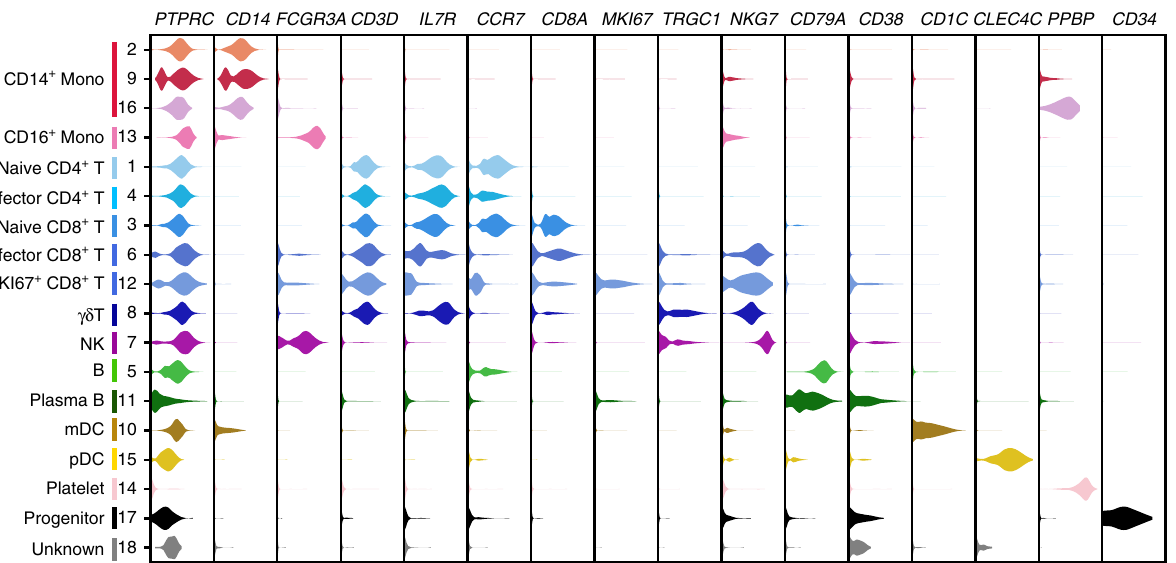
Fig. 1 An atlas of peripheral immune cells in severe COVID-19 patients. a Flowchart depicting the overall design of the study. Blood draws from patient P1 were performed at 2 time points (day 1 and day 5) and from P2 at 3 time points (day 1, day 5 and day 7). P1 on day 1 and P2 on day 1 and day 5 were positive based on a nucleic acid test of a throat swab specimen. P1 on day 5 and P2 on day 7 were negative based on a nucleic acid test of a throat swab specimen. Patients on day 1 were at the severe stage, and patients were in the remission stage on day 5 (P1 and P2); the day 7 blood draw for P2 (still in the remission stage) was performed based on a positive nucleic acid test on day 5. Note that the samples on day 1 were collected within 12 hours of tocilizumab treatment. b - d UMAP representations of integrated single-cell transcriptomes of 69,237 PBMCs, with 13,239 cells derived from our COVID-19 patients and 55,998 derived from the 10X Genomics of fi cial website 16 . Cells are colour-coded by clusters ( b ), disease state ( c ), and sample origin ( d ). Dotted circles represent cell types with a > 5% proportion within PBMCs in ( b ), and clusters signi fi cantly enriched in patients versus controls are shown in ( c , d ). Mono, monocyte; NK, natural killer cells; mDCs, myeloid dendritic cells; pDCs, plasmacytoid dendritic cells. e Violin plots of selected marker genes (upper row) for multiple cell subpopulations. The left column presents the cell subtypes identi fi ed based on combinations of marker